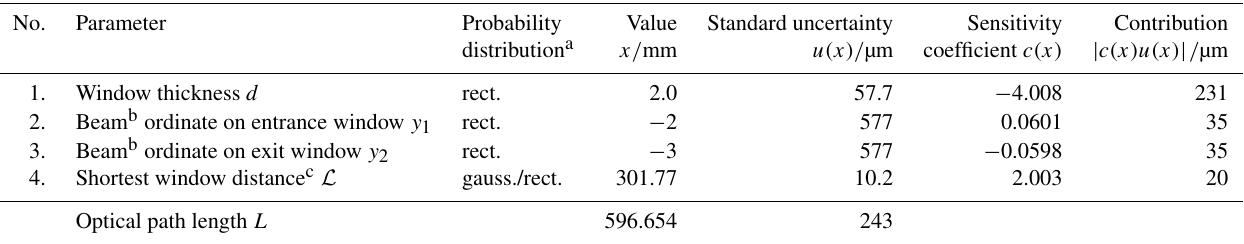
Optical path length